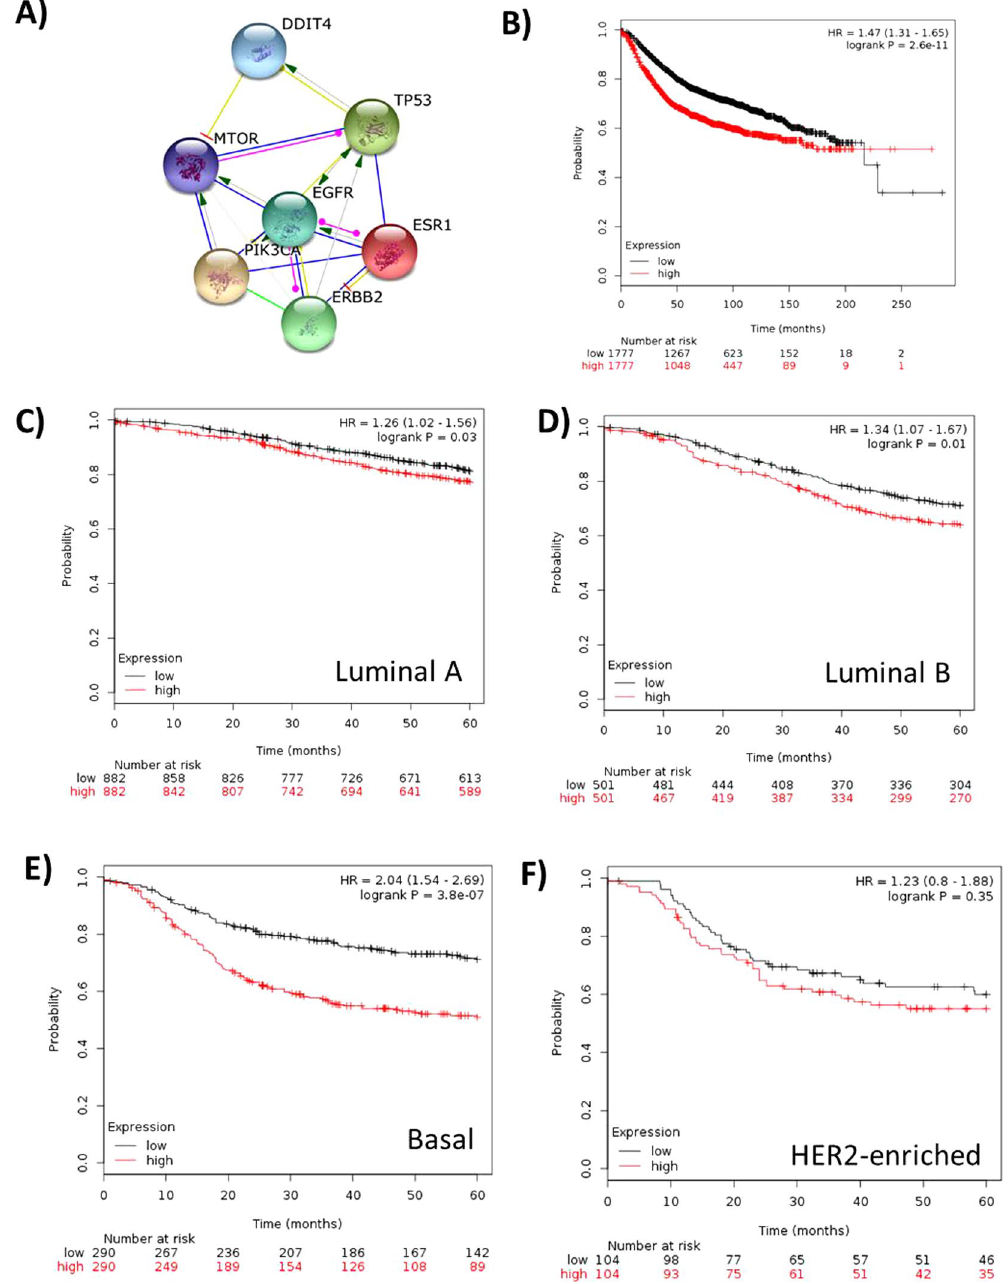
Figure 2. Evaluation of DDIT4 expression in the survival of breast cancer patients. ( A ) Protein interaction of DDIT4 with genes relevant in breast cancer. ( B ) Analysis in KM-Plotter shows that high DDIT4 expression is related with a poor prognosis [P = 2.6 × 10 − 11]. In 5-years censored data, ( C ) DDIT4 was a prognostic factor in Luminal A [P = 0.003], ( D ) Luminal B [P = 0.001] and ( E ) Basal subtype [P = 3.8 × 10 − 7]. ( F ) DDIT4 was not related with the outcome in patients with HER2-enriched